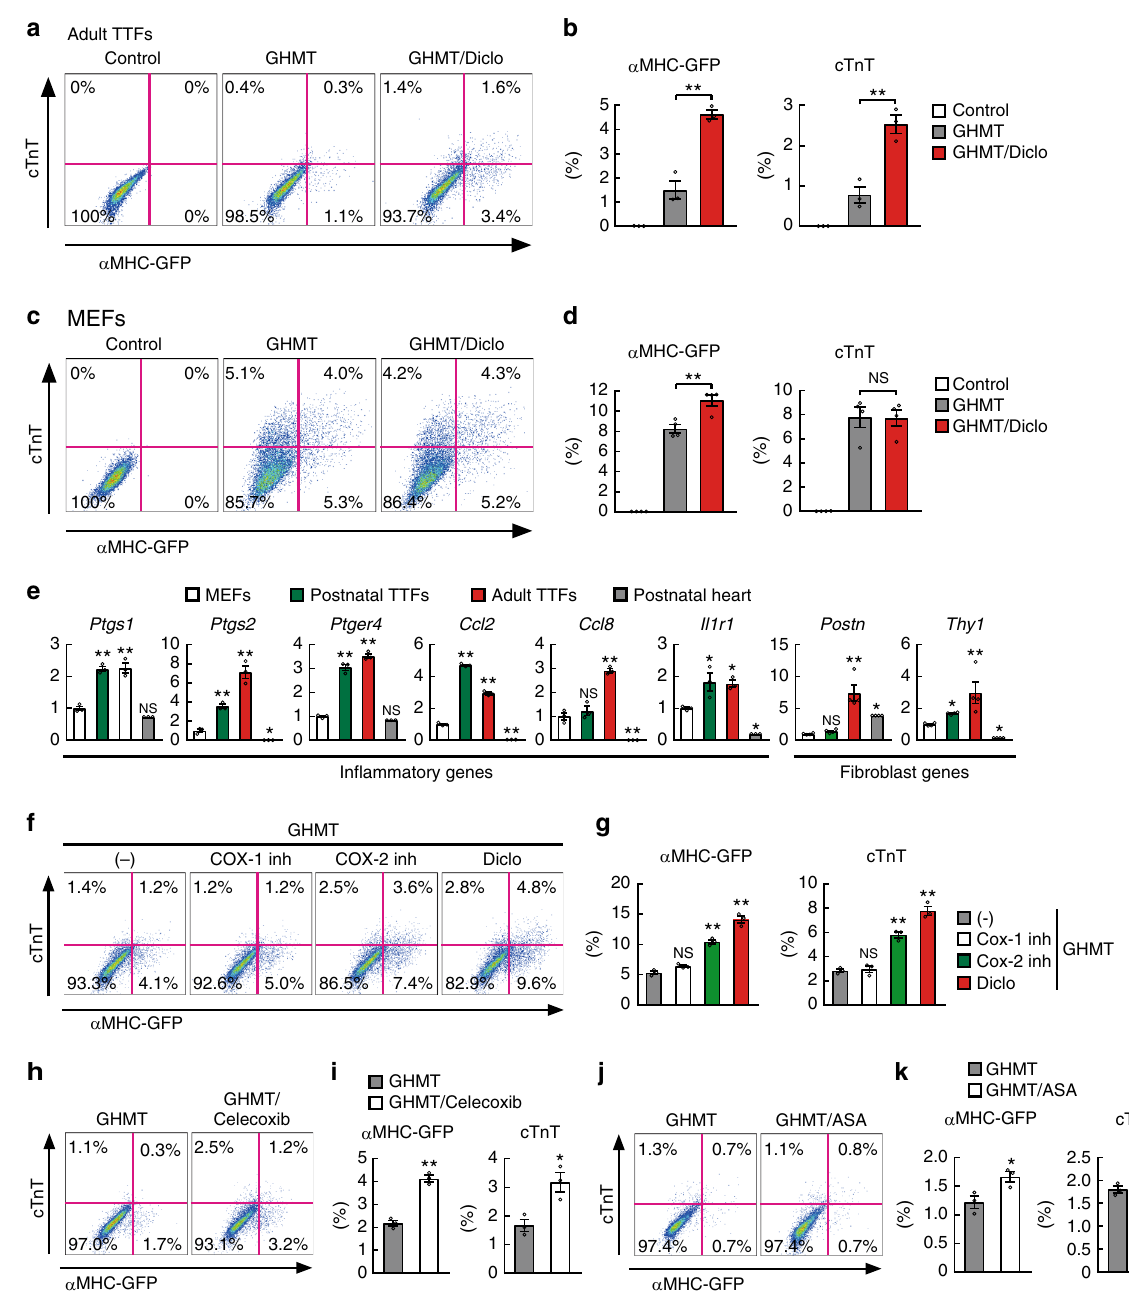
Fig. 3 Diclofenac promotes cardiac reprogramming in adult TTFs but not in MEFs. a , b FACS analyses for α MHC-GFP and cTnT expression in adult TTFs transduced with GHMT and cultured with or without diclofenac for 1 week. Quantitative data are shown in b ; n = 3 biologically independent experiments. See also Supplementary Figure 2. c , d FACS analyses for α MHC-GFP and cTnT expression in MEFs transduced with GHMT and cultured with or without diclofenac for 1 week. Quantitative data are shown in d ; n = 3 biologically independent experiments. e Relative mRNA expression levels were determined in MEFs, postnatal and adult TTFs, and postnatal heats by qRT-PCR; n = 3 biologically independent experiments. f , g FACS analyses for α MHC-GFP and cTnT expression in postnatal TTFs transduced with GHMT and treated with indicated reagents for 1 week; inh indicates inhibitor. Quantitative data are shown in g ; n = 3 biologically independent experiments. h – k FACS analyses for α MHC-GFP and cTnT expression in postnatal TTFs transduced with GHMT and treated with celecoxib ( h ) or acetylsalicylic acid (ASA, j ) for 1 week. Quantitative data are shown in i and k , respectively; n = 3 biologically independent experiments. Student ’ s t -test was performed for b , d , i , k , one-way ANOVA with Dunnett ’ s post hoc test was performed for e , g ; all data are presented as mean ± SEM. * P < 0.05, ** P < 0.01 vs. the relevant control. NS, not signi fi cant. Diclo,